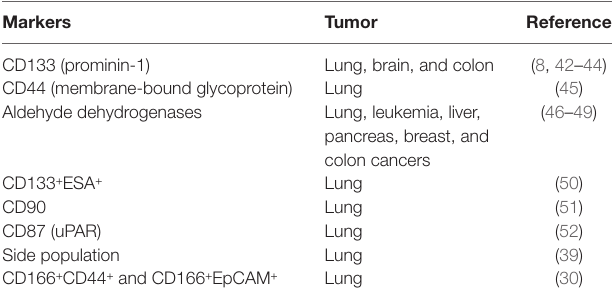
TaBLe 1 | List of markers used for identification of CSC in various tumor.